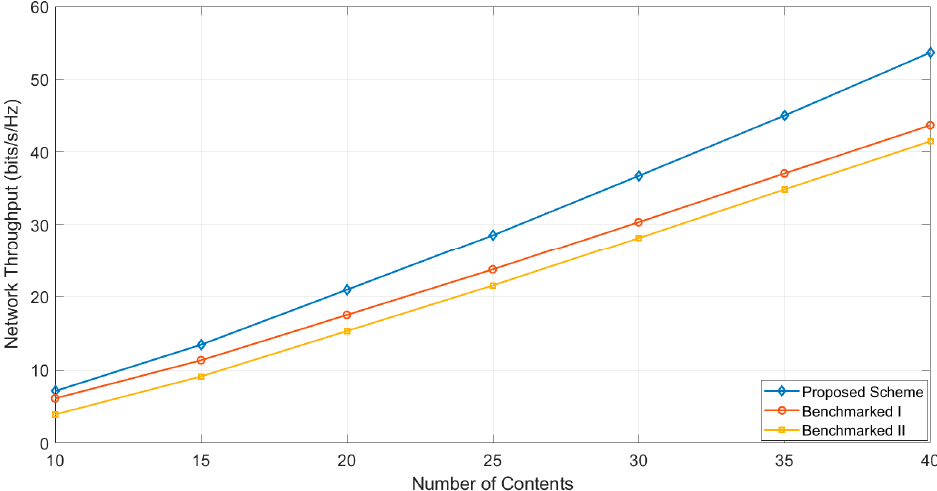
Figure 6. Network throughput V/S number of contents.